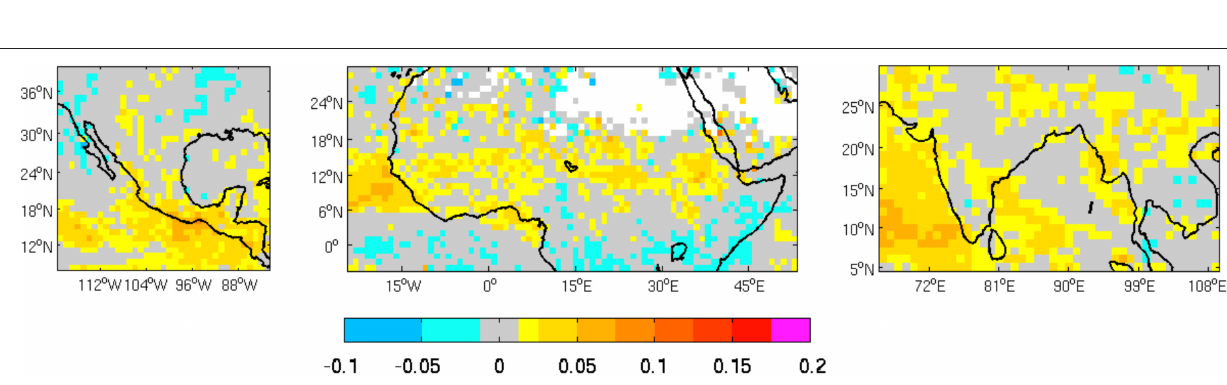
Frontiers in Environmental Science |